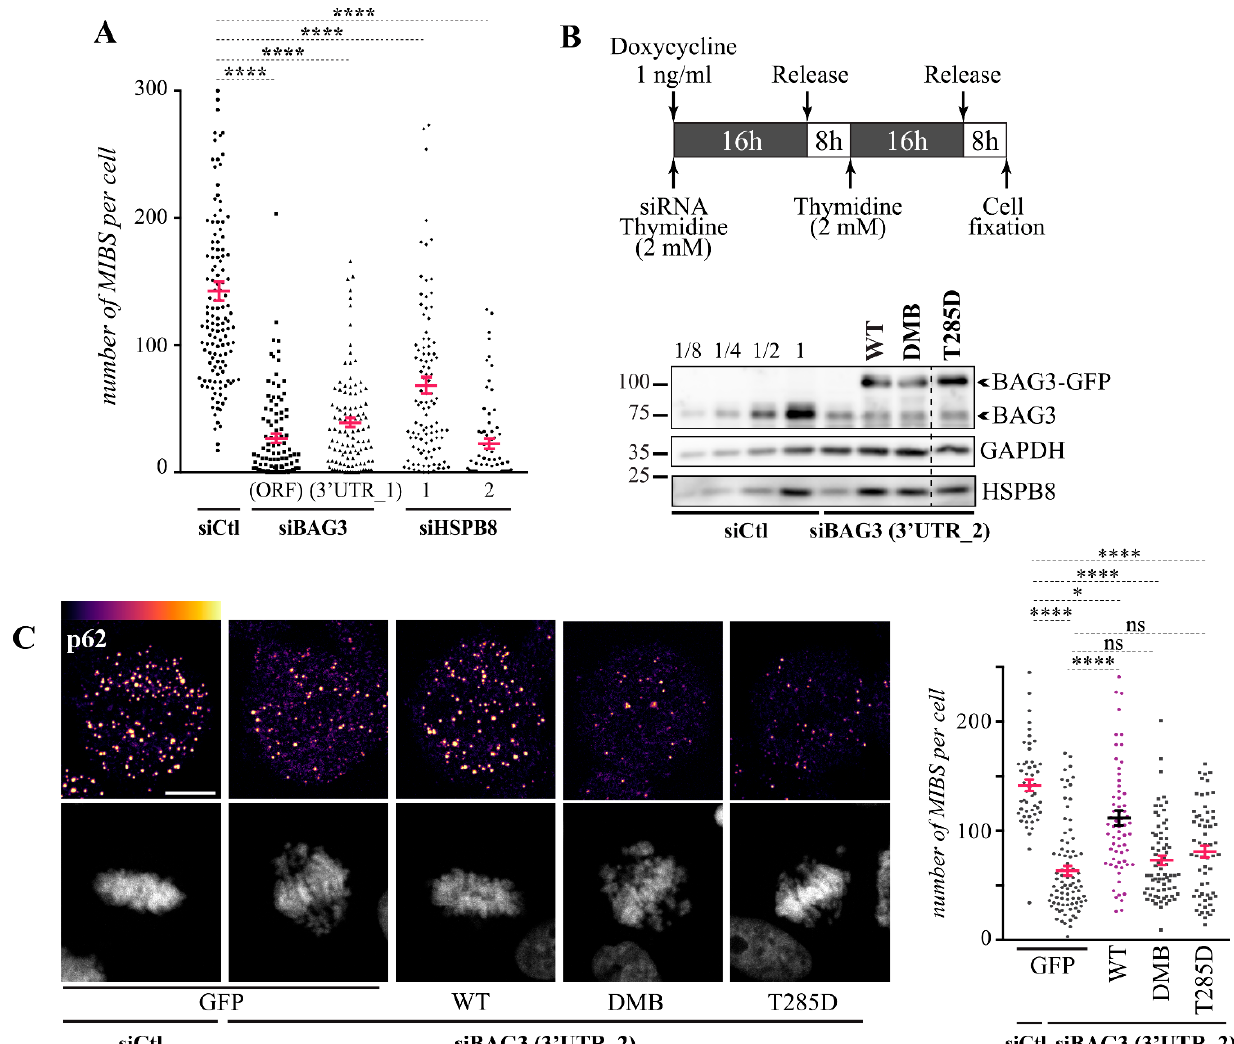
Figure 7. The molecular assembly of p62-MIBS depends on BAG3 phosphorylation and HSPB8. ( A ) Quantification of MIBS number per cell (prometaphase-metaphase) in HeLa cells transfected with control siRNA (siCtl) or BAG3-specific or HSPB8-specific siRNAs, and stained for endogenous p62, α -tubulin, and DNA; means ± SE from 70 to 136 cells from at